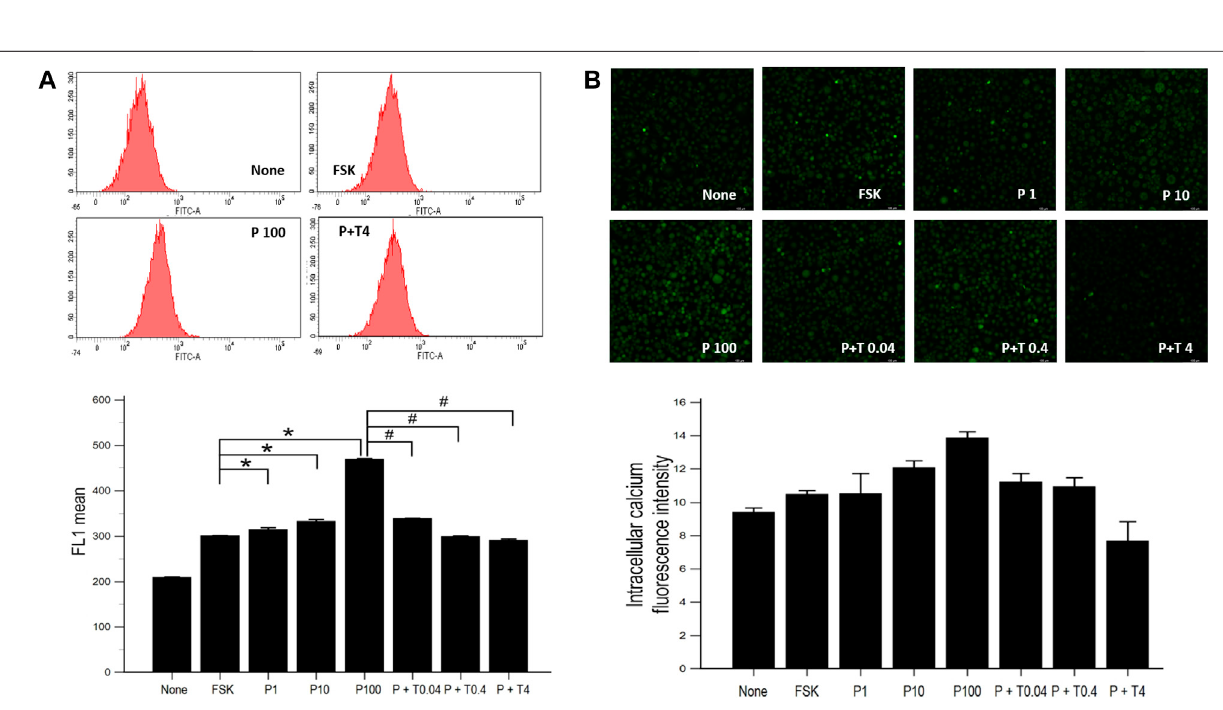
cells treated with forskolin ( p < 0.05). Treatment with 4 ng/ml TMI-1 decreased the levels of PKC, PI3K, and NF- κ B ( p < 0.005, p < 0.05, and p < 0.005, respectively). The low dose (0.04 ng/ml)